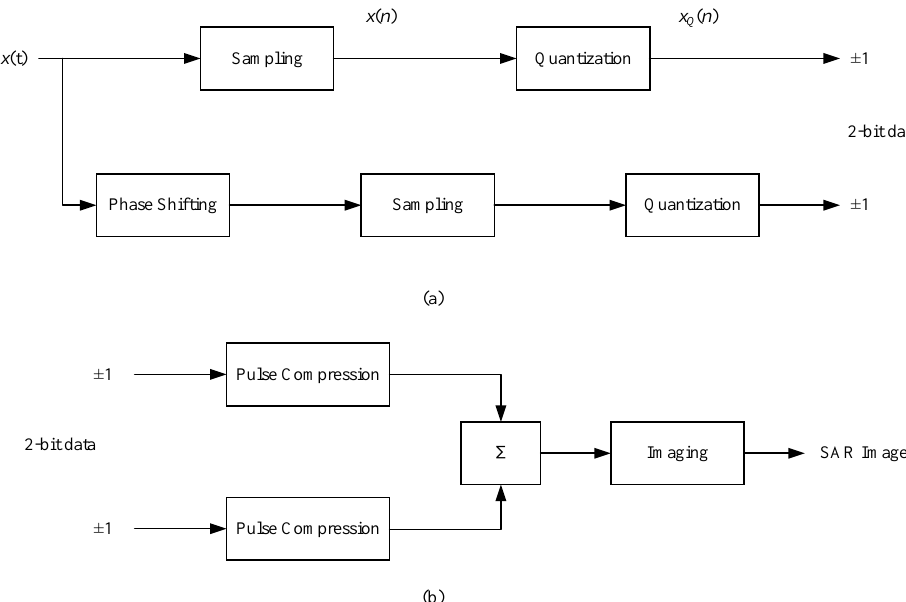
Figure 1. Block diagrams of the proposed two-bit imaging strategy. ( a ) Procedure of two-bit sampling. ( b ) Procedure of two-bit